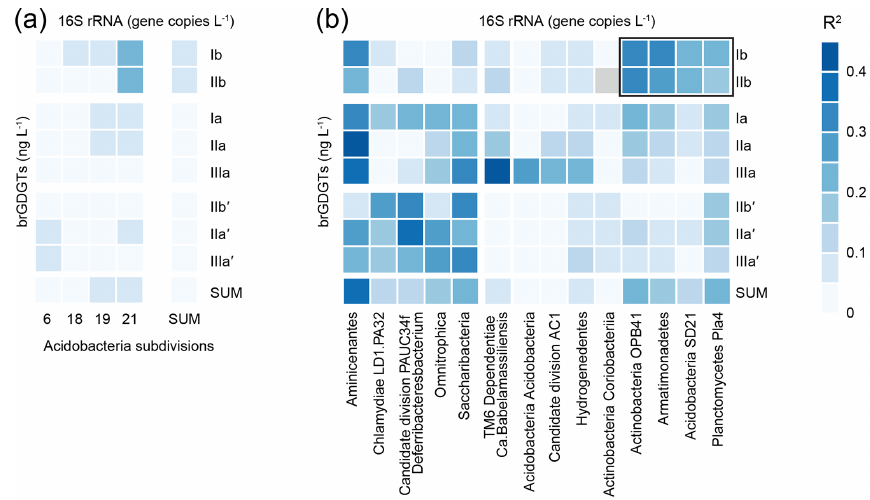
Figure 8. Correlation matrix ( R 2 ; represented by shades of blue) between the absolute concentration of the eight major brGDGTs in Lake Chala SPM (ngL − 1 ) and estimated 16S rRNA gene abundances (copiesL − 1 , see details in text). (a) Acidobacteria SD 6, 18, 19, and 21 and the sum of all Acidobacteria. The Acidobacterial SD operational taxonomic unit (OTUs) are present in at least 10% of the SPM samples measured for both brGDGTs and gene abundances. Only SDs that correlate with at least one brGDGT with an R 2 ≥ 0 . 05 are shown. (b) The 14 taxa of bacteria displaying highest correlation with individual brGDGTs, divided into clusters of highest correlation with Ib and IIb or with the other brGDGTs. The bacterial OTUs are present in at least 10% of the SPM samples measured for both biomarkers and gene abundances. Only SDs that correlate with at least one brGDGT with R 2 ≥ 0 . 2 are